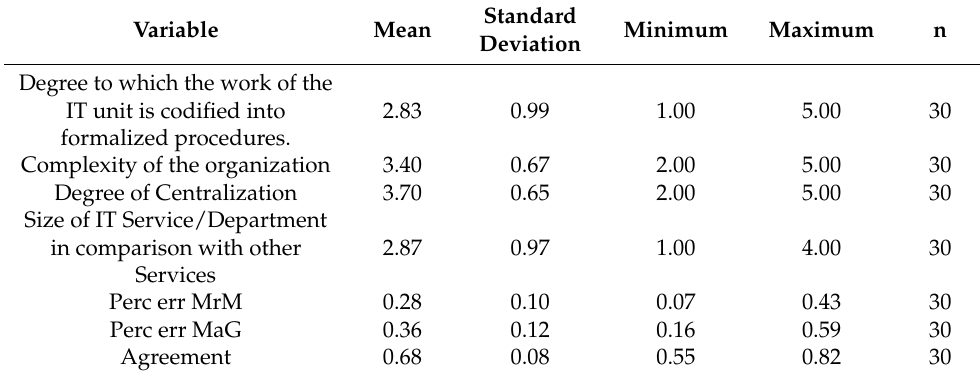
Table 5. Descriptive statistics of Group